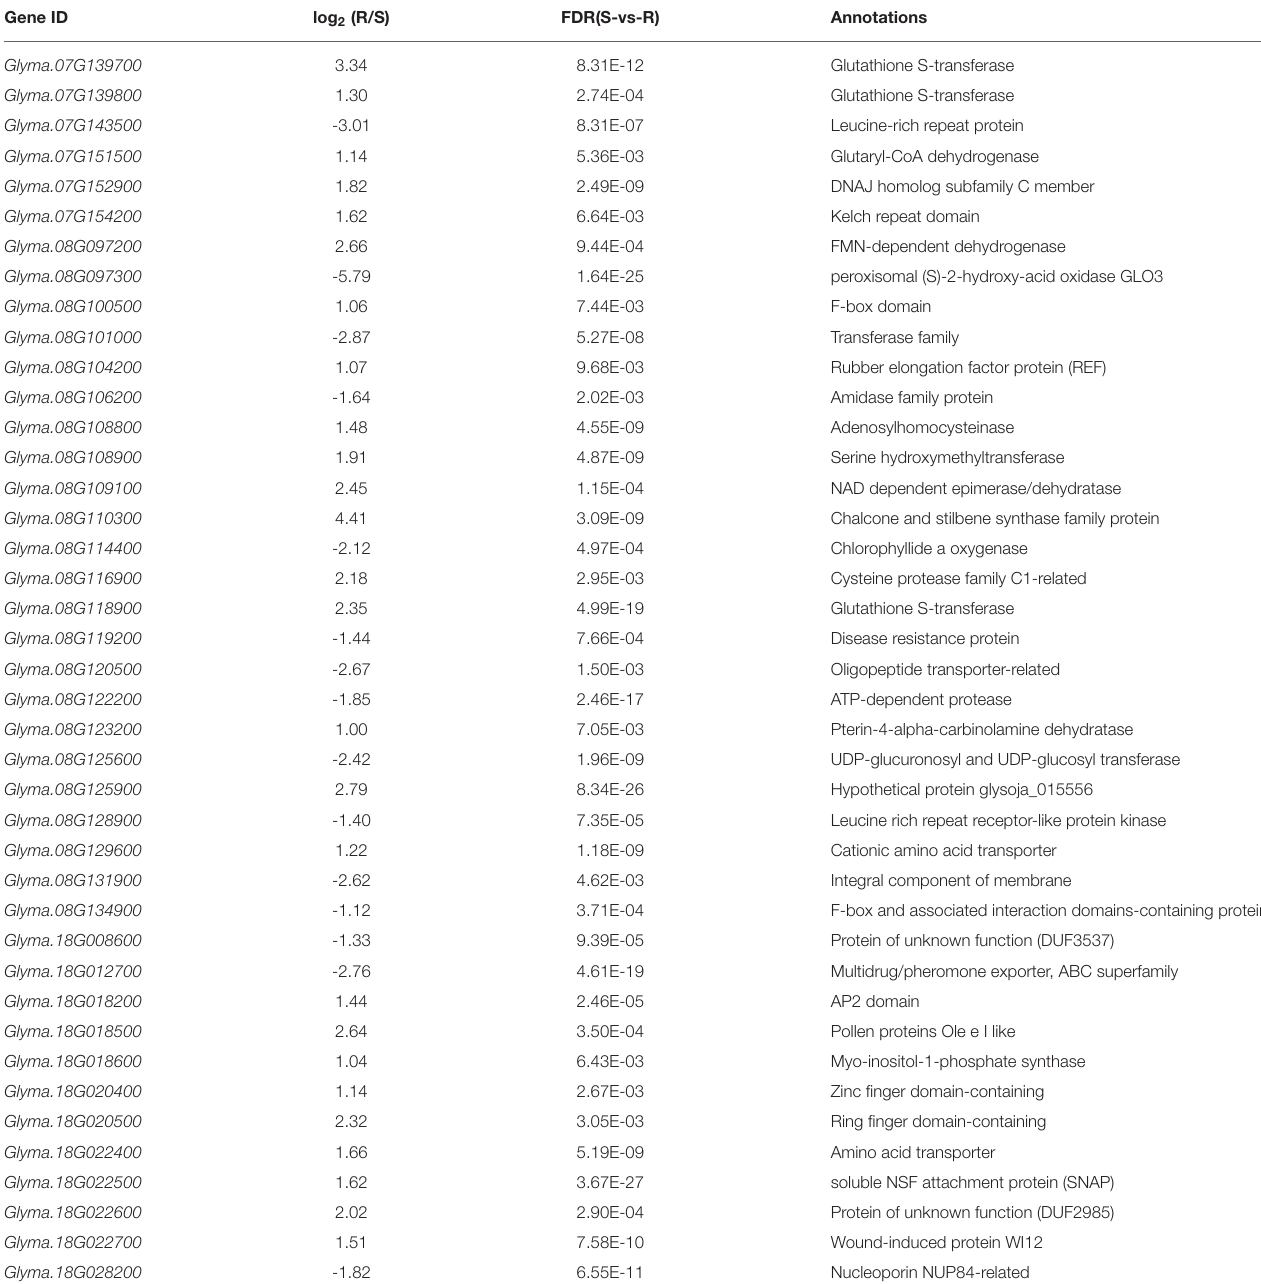
TABLE 5 | Candidate genes at three QTLs ( SCN_7_1 , SCN_8_2 , and SCN_18_6 ). Gene ID log 2 (R/S)